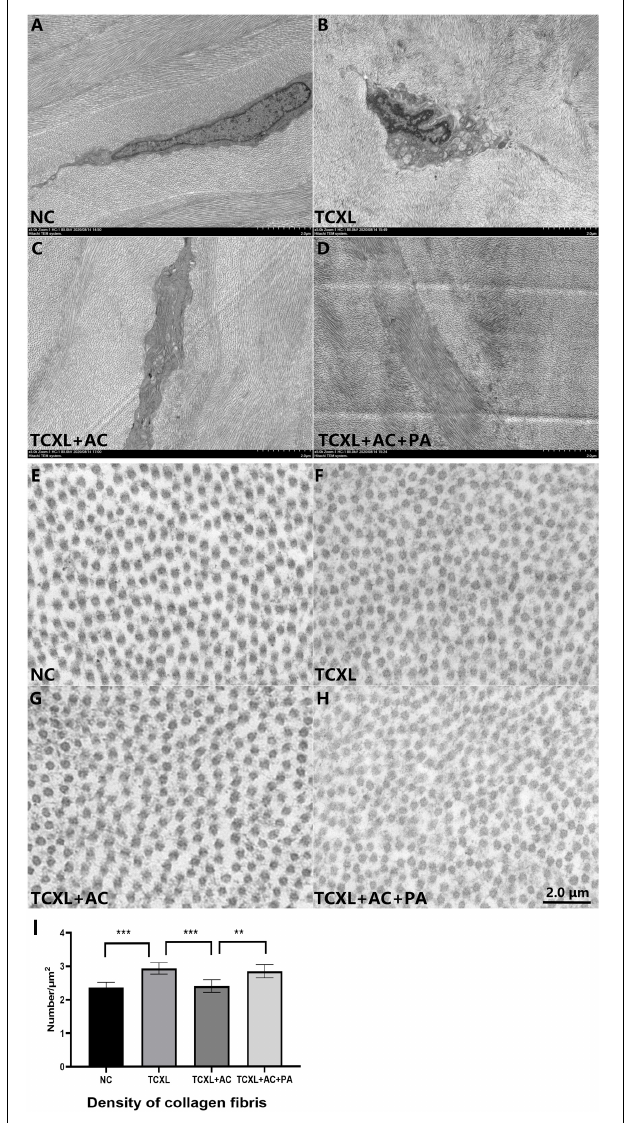
FIGURE 5 | Representative images of transmission electron microscopy showing the ultrastructural changes in corneal stroma on D28. Parallel running collagen fibril lamellae were present in the anterior stroma of normal control (A) , while obviously interlacing lamellae were present in the TCXL group (B) . In TCXL + AC group, parallel running and interlacing fibril lamellae were both present (C) , but the fibril lamellae were still obviously interlacing in TCXL + AC + PA group (D) . Cross section of the collagen fibrils showing the interfibrillar spacing in the TCXL cornea (F,I) was lower than that of normal control (E,I) and TCXL+AC group (G,I) , but was comparable with that of TCXL+AC+PA group (H,I) . (A–D) Magnification 5000 × ; (E–H) magnification 45000 ×